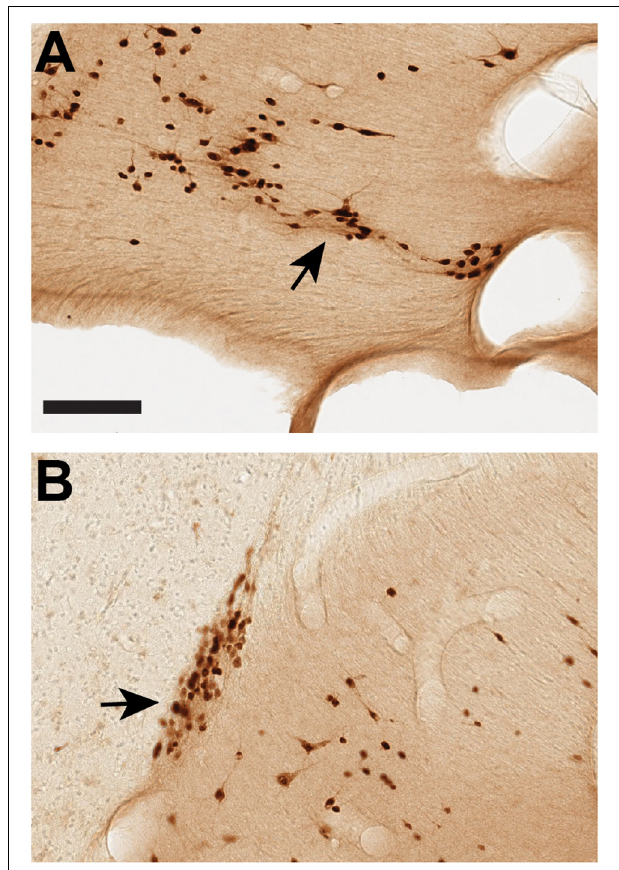
FIGURE 6 | Cells within the stria terminalis (ST) can associate with ("coat") blood vessels, as shown by two examples from vST (arrows) processed for NeuN in B61 section 34 (A) and B65 section 35 (B) . Medial is to the left. Scale bar = 100 µ m.